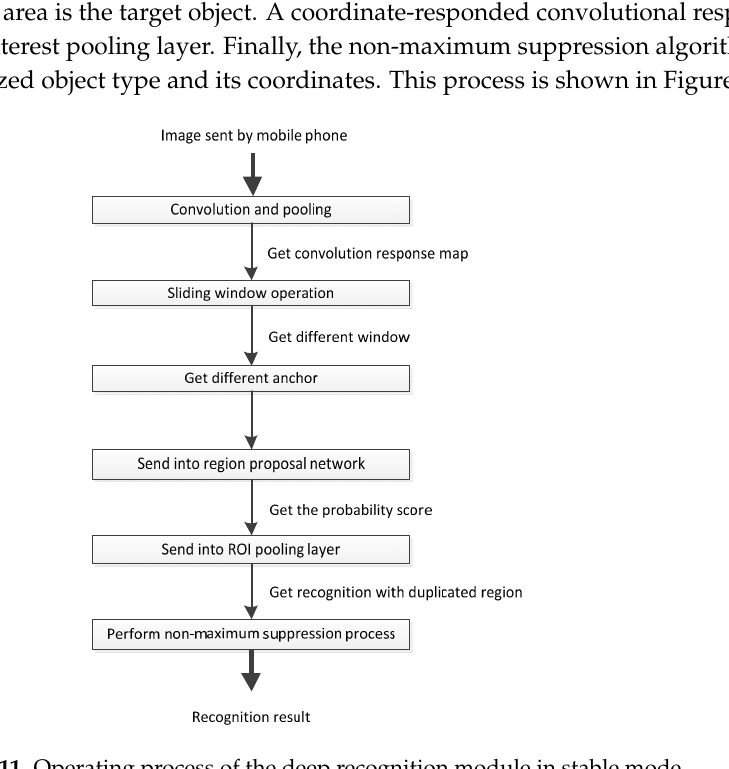
Figure 11. Operating process of the deep recognition module in stable mode.